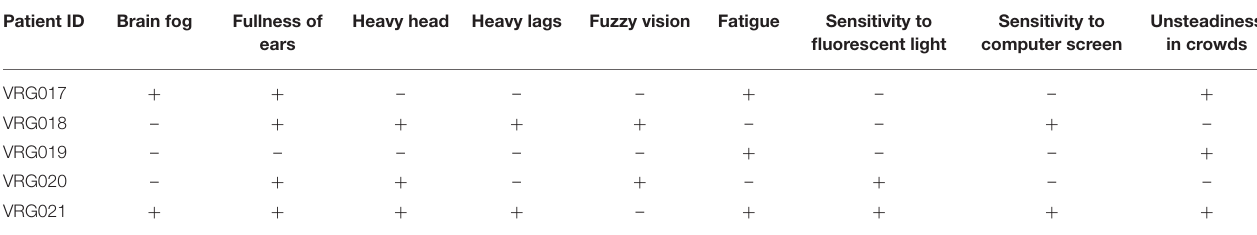
TABLE 3 | Psychosomatic symptoms reported by patients. Patient